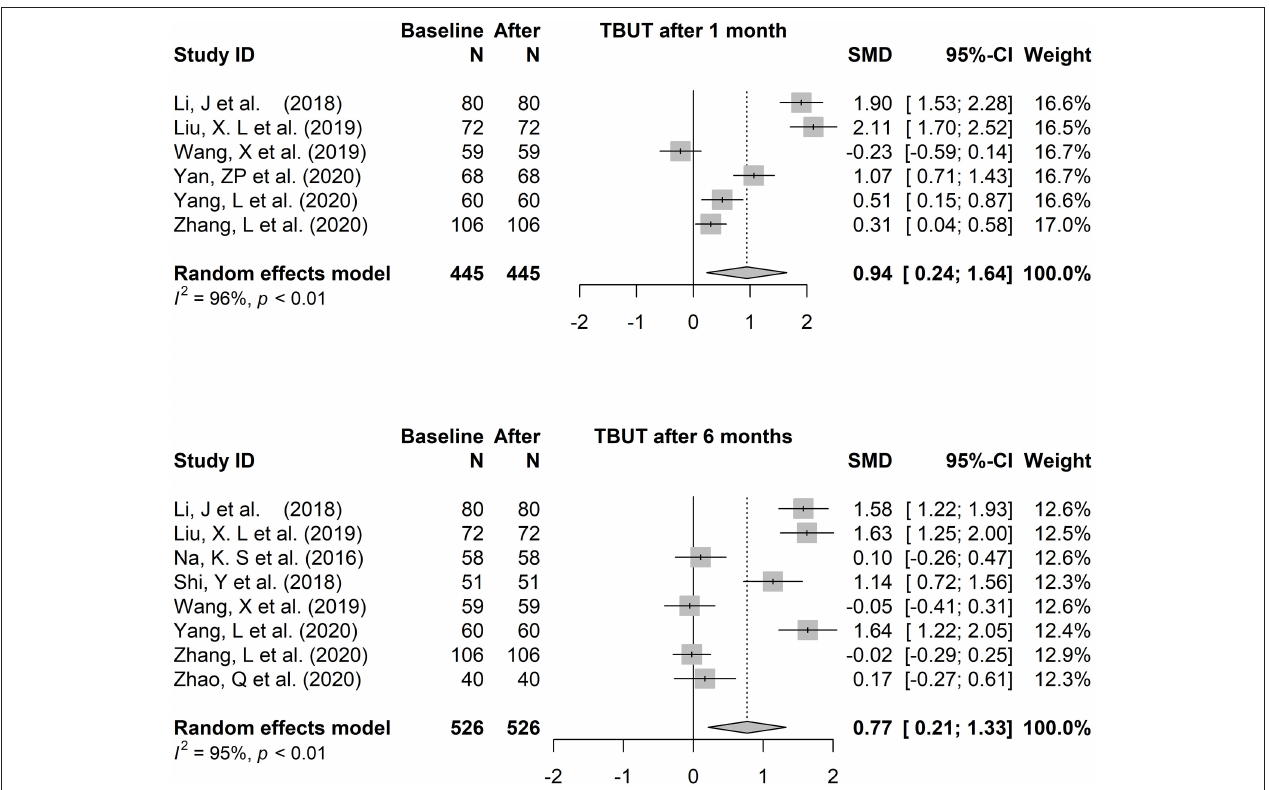
FIGURE 3 | The forest plots of tear break-up time changing after one to 6 months of orthokeratology wearing.